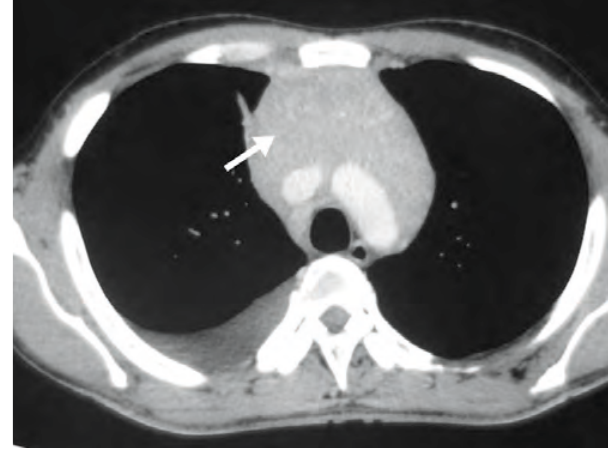
Fig. 6. Axial CT image showing homogenously enhancing soft tissue anterior mediastinal mass (arrow) replacing the thymus in a case of thymic lymphoma.